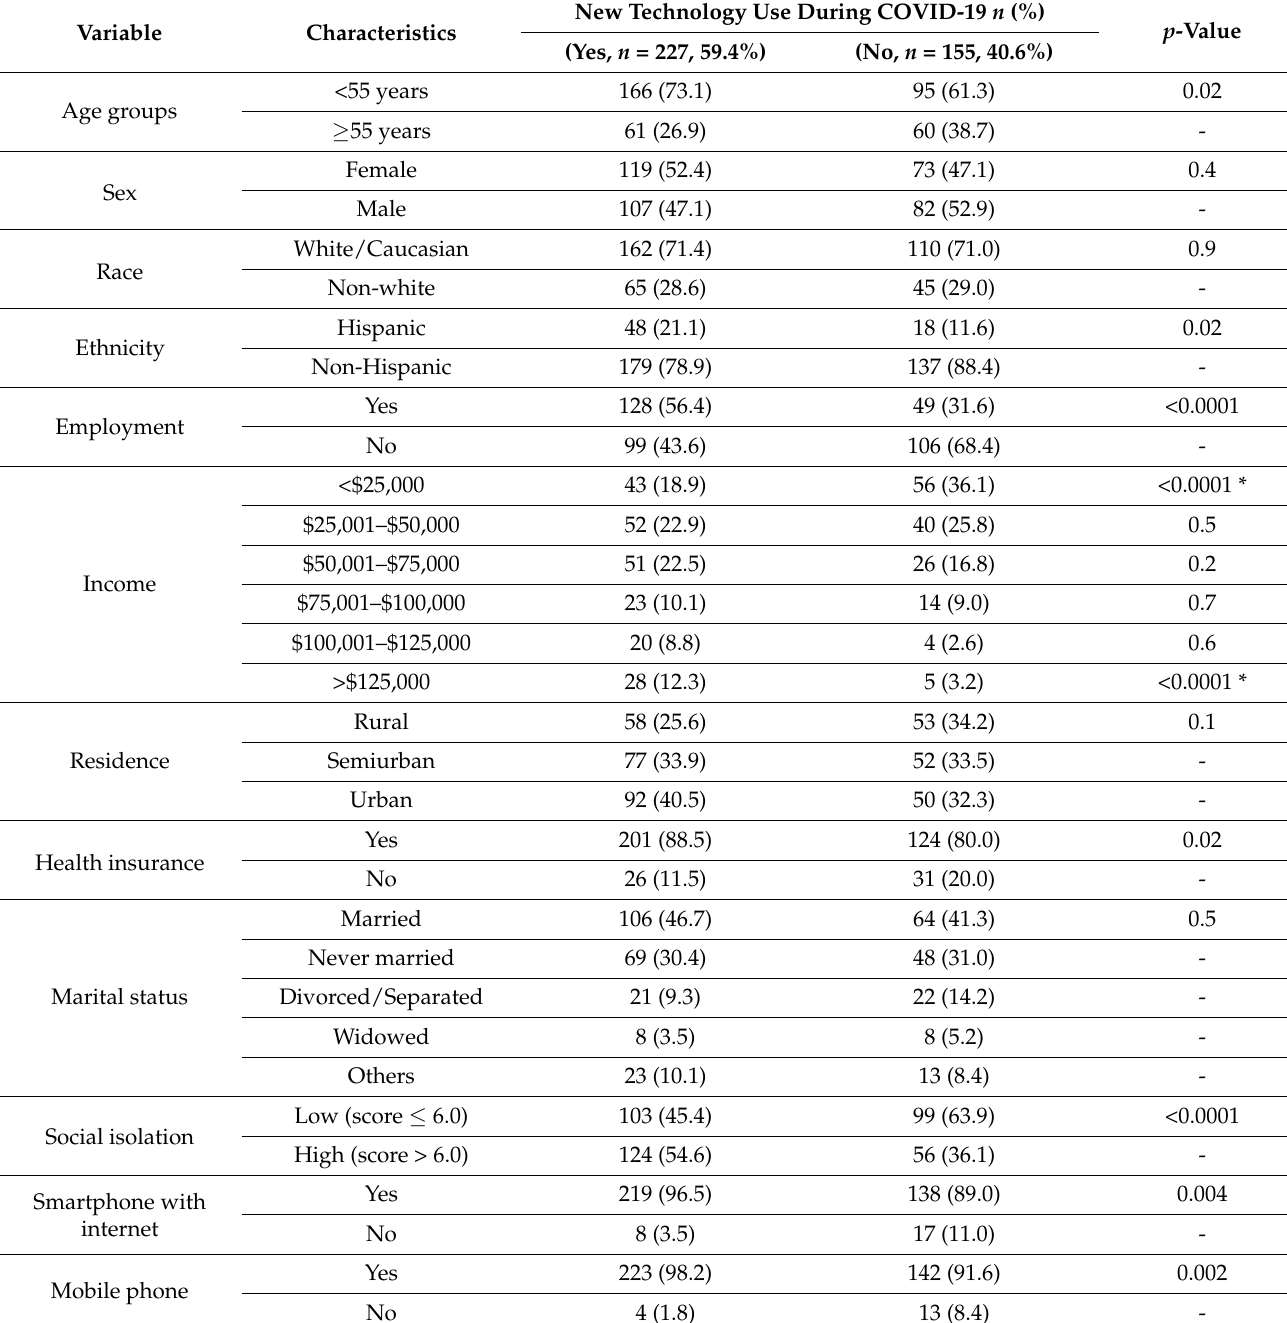
Table 2. Comparison of categories across technology users and non-users, ( n = 382). Variable